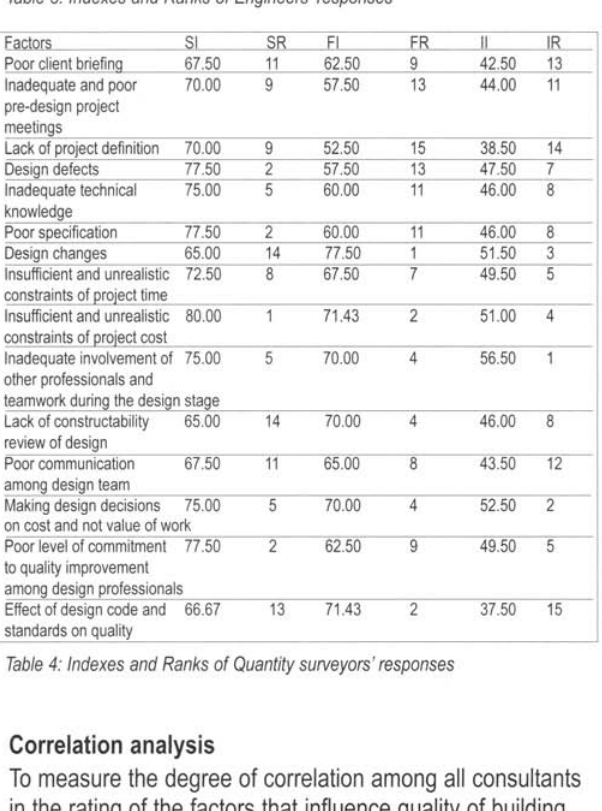
Table 4: Indexes and Ranks of Quantity sUlVeyors' responses